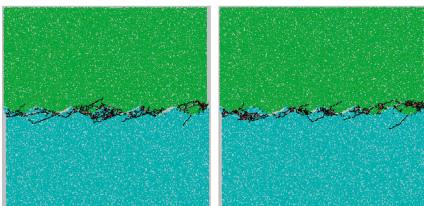
Normal stress of 1.0 MPa Normal stress of 2.0 MPa